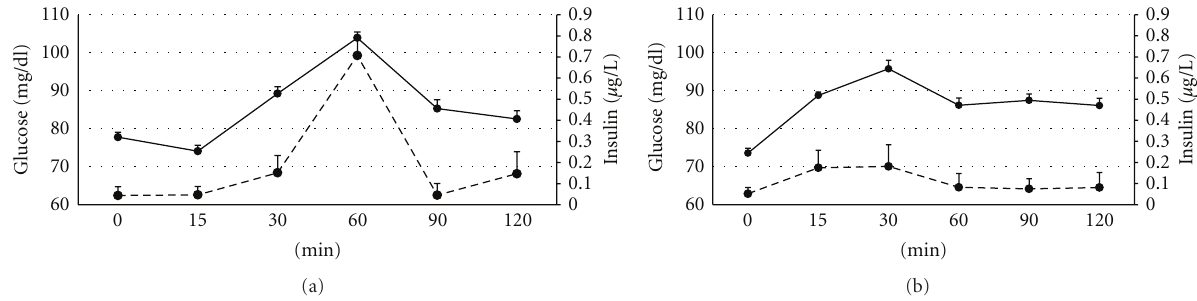
Figure 4: Changes in plasma concentration of glucose (continuous line) and insulin (discontinuous line) over time after oral administration of 2g/kg live weight of D-glucose in control sows (a) and sows with ad libitum access to a diet enriched with saturated fat (b).